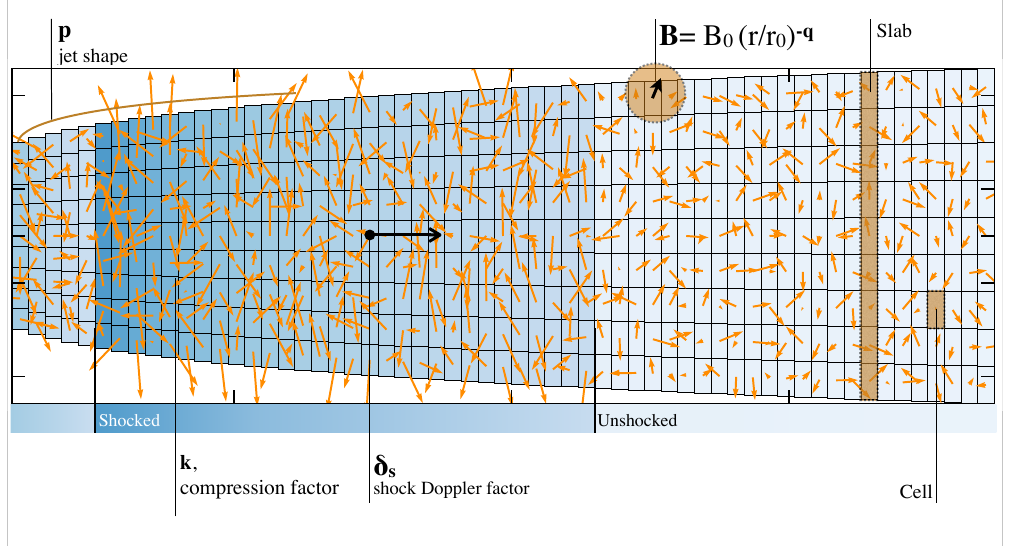
Figure 2. A modeled jet profile and some key parameters of the radiative transfer code. The density gradient along the jet axis is demonstrated by the color shading of the cells. The orange arrows show the projection of magnetic field on the plane of the